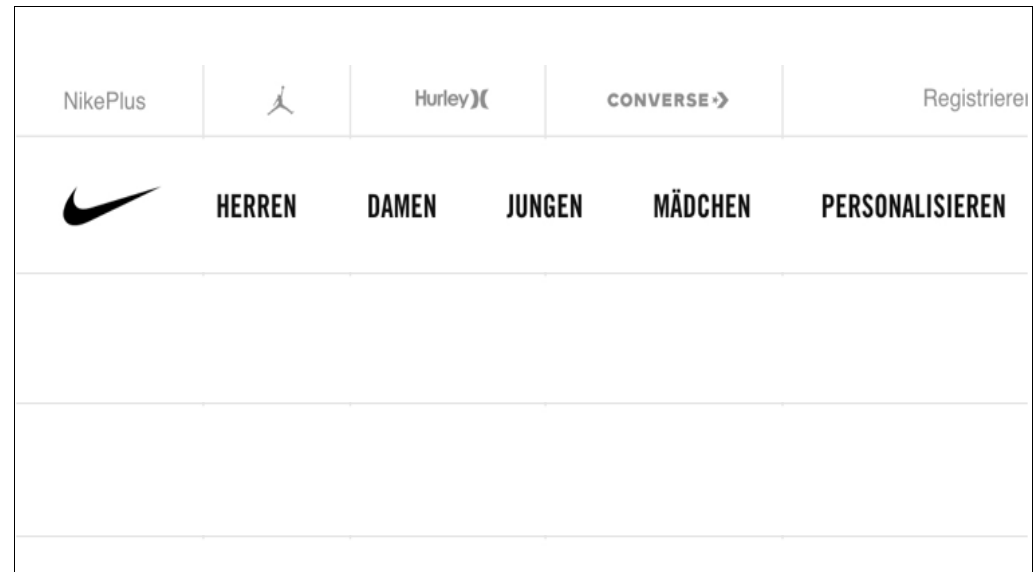
Figure 3 (bottom): Also newsletter registration includes gender classification. In addition to e-mail address and the age check, only gender is verbally encoded and entered under “shopping preferences” as a mandatory field. Source: http://nike.com/de/de_de. Accessed: November 19,